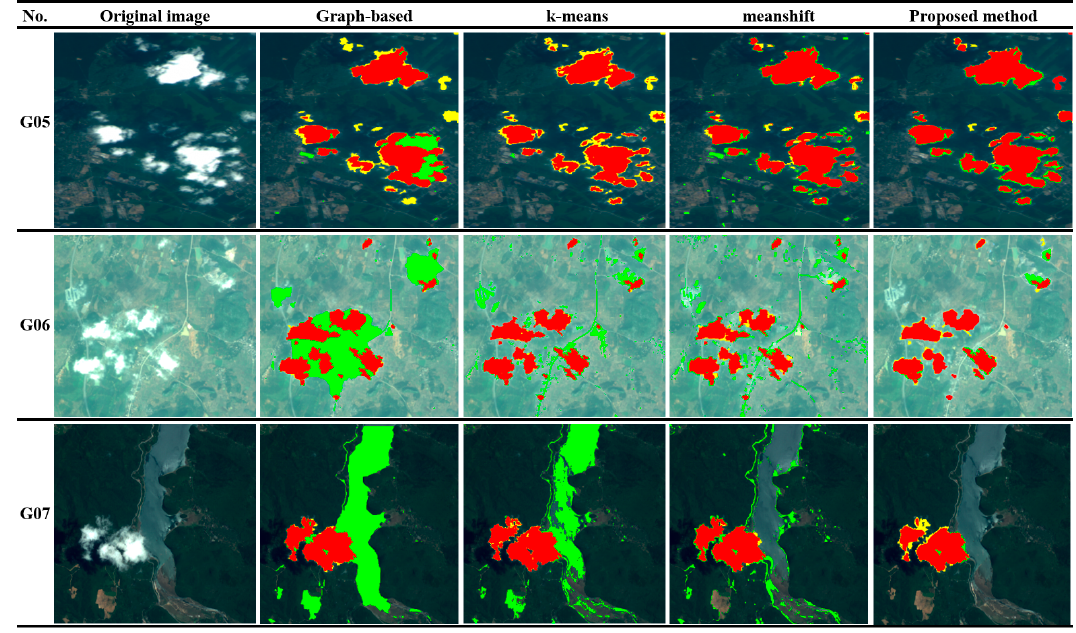
Figure 17. Results of comparison with automatic image segmentation algorithms (Red denotes the extracted true cloud regions, yellow denotes the missed true cloud regions, green denotes the non-cloud regions misjudged as cloud regions).